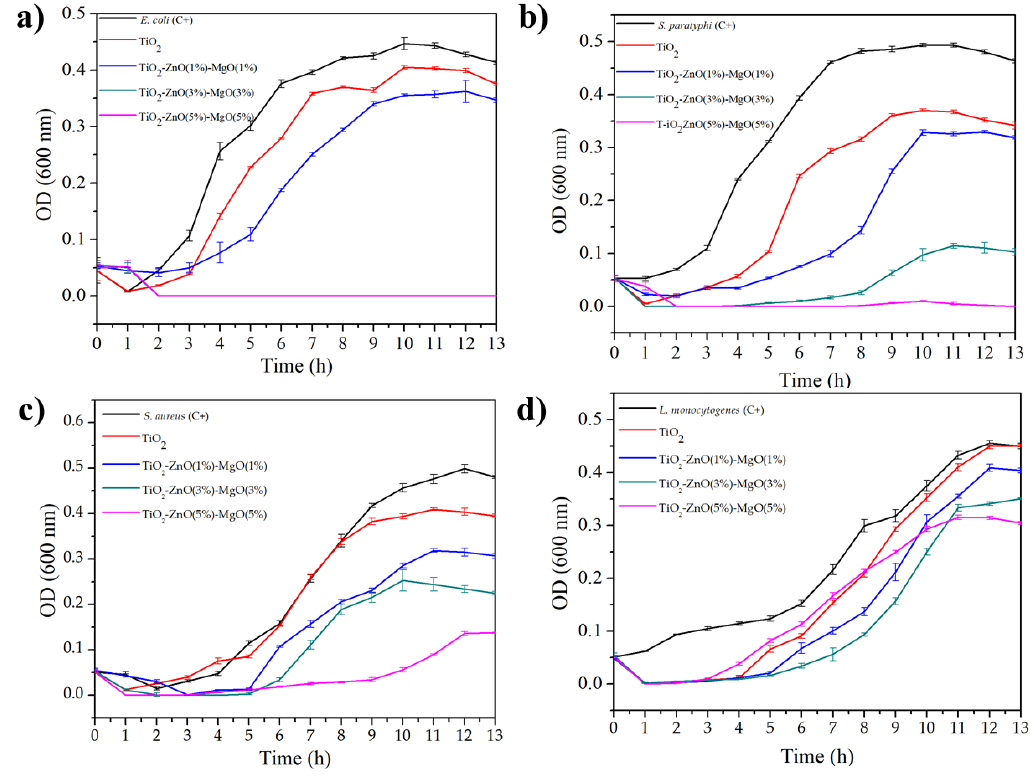
Figure 3. Growth curves profiling of E. coli ( a ), S. paratyphi ( b ), S. aureus ( c ) and L. monocytogenes ( d ) exposed to TiO 2 and mixed oxide nanoparticles.